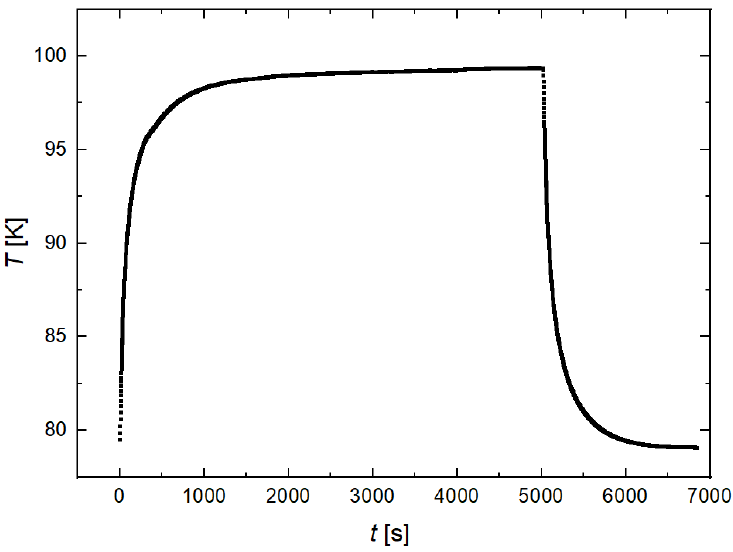
Figure 15. Typical variation in the operating temperature of the PCS during test.